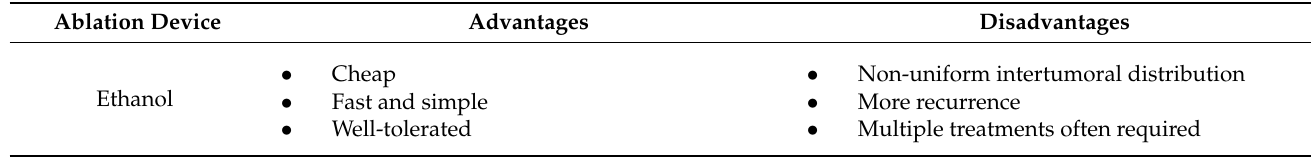
Figure 1. Flowchart of ablation modalities. Ablation modalities can be subdivided into thermal and non-thermal based modalities. Thermal ablation modalities include radiofrequency ablation (RFA), microwave ablation (MWA), cryoablation, and laser ablation. Non-thermal ablation modalities include chemical ablation (ethanol and acetic acid ablation), irreversible electroporation (IRE), and external energy delivery modalities (high intensity focused ultrasound (HIFU) and histotripsy). Table 1. The advantages and disadvantages of the common ablation